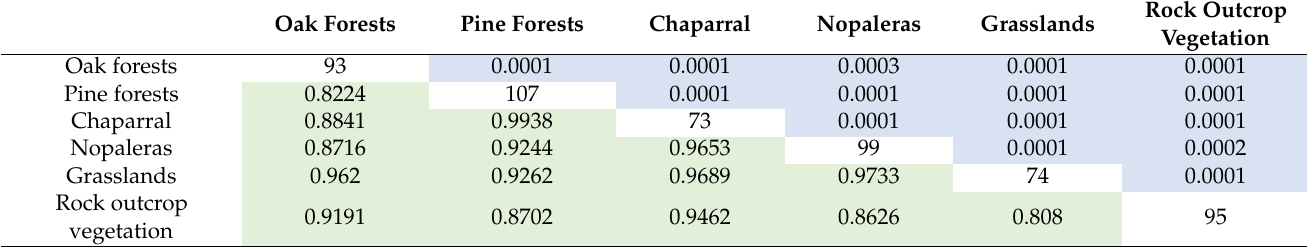
Figure 2. Nonmetric multidimensional scaling analysis (N-MDS) calculated with the Bray–Curtis similarity index (Stress of 0.3). 1 = oak forests; 2 = pine forests; 3 = chaparral; 4 = nopaleras; 5 = grasslands; 6 = rock outcrop vegetation. Each point represents a sampling site, and the distance between them represents dissimilarity. Table 1. Analysis of similarities (ANOSIM) between the main plant communities present in the Sierra de los Cardos, Susticacán, Zacatecas, Mexico. Green cells indicate R values, blue cells indicate the associated p -value, and white cells indicate the total number of species per plant community.